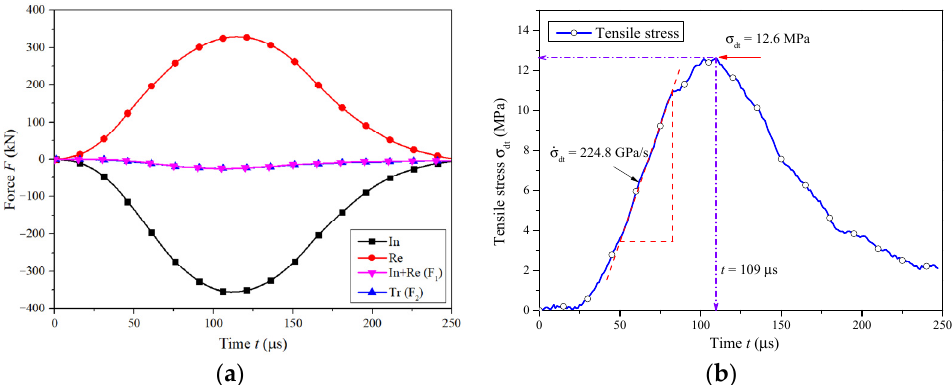
Figure 6. Verification of the dynamic force balance at both ends of the sample ( a ) and the determi- nation of the loading rate ( b ).